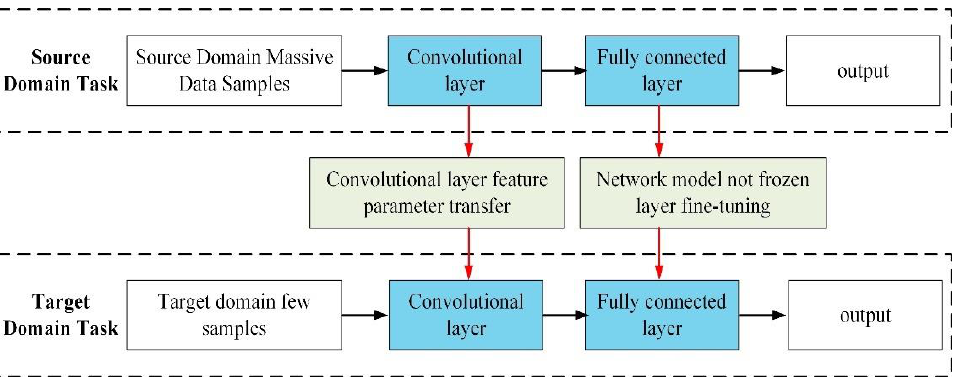
Figure 6. The schematic diagram of the model migration